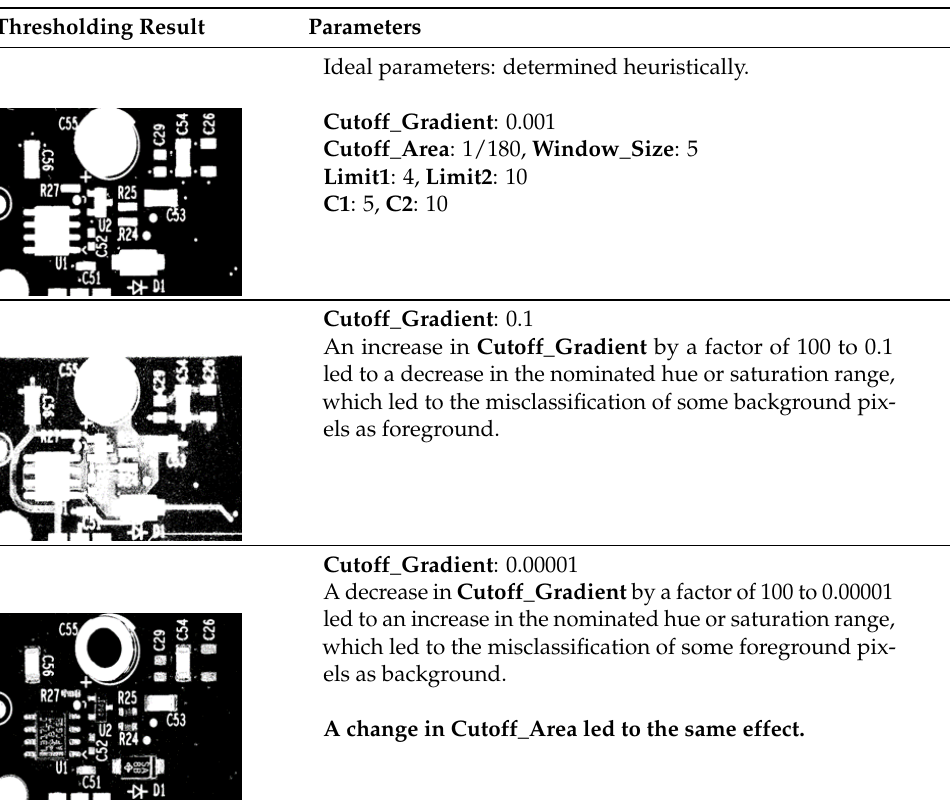
Figure A2. The input image used to test different configurations of the parameters. Table A4. Example configurations of